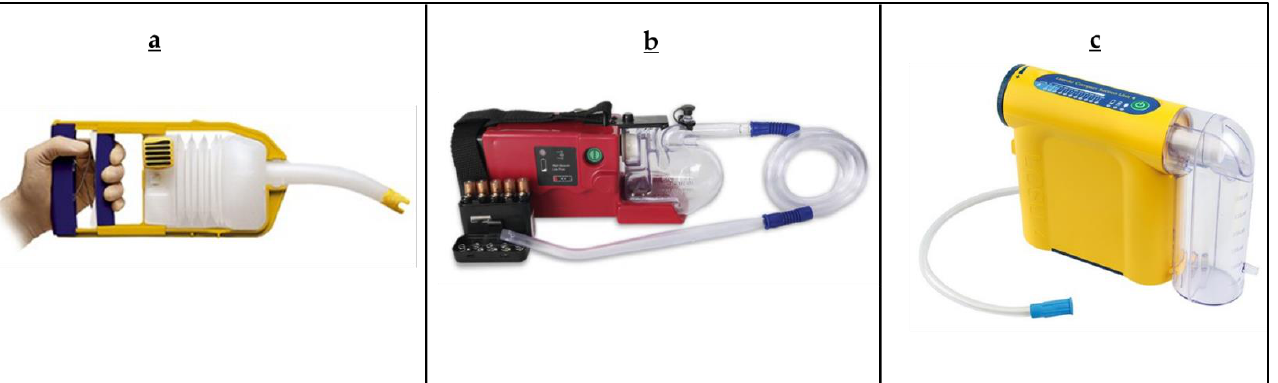
Figure 1. Commercially available portable suction devices, ( a ) Manually operated portable suction device — Laerdal VVAC [27]; ( b ) Battery operated portable suction device — SSCOR Quickdraw [28]; ( c ) Battery operated suction device — Laerdal LCSU 4 [29]. Reprinted with permission to reprint im- ages of the portable suction devices were obtained from respective manufacturers. ( c ) Battery operated suction device—Laerdal LCSU 4 [29]. Reprinted with permission to